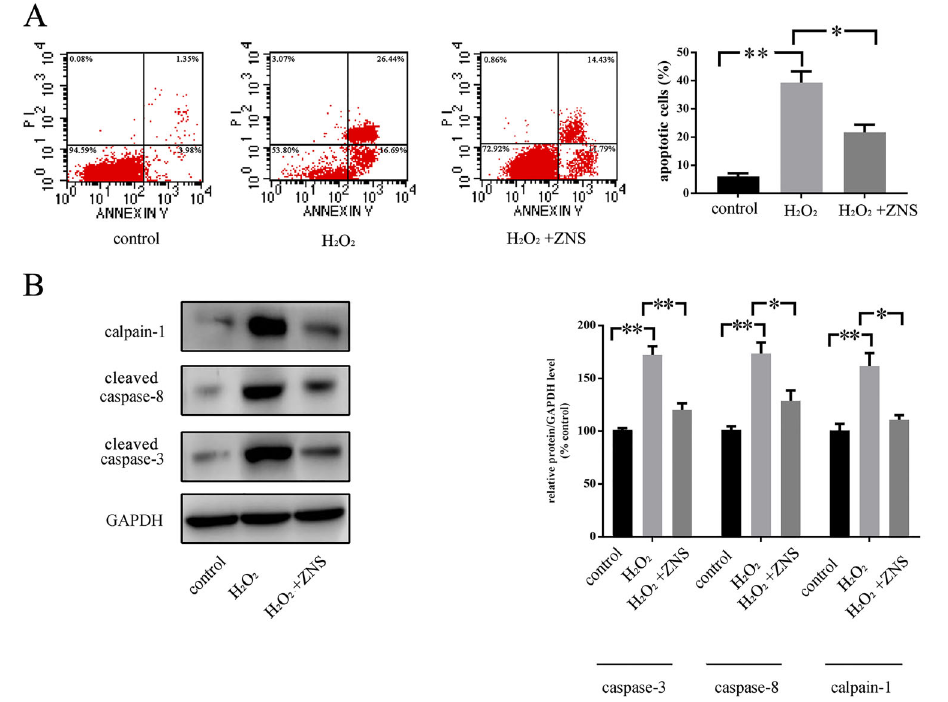
Figure 2. The cells received zonisamide (ZNS) or H 2 O 2 , for 24 h. A , Cells stained with annexin V and PI, showing the number of apoptotic (annexin V-positive) cells as the percentage of gated cells. B , Apoptosis-related protein expression in cells after different treatments via western blot (representative images and relative quanti fi cations are shown). All the experiments were performed in triplicate, and the data are reported as means ± SE (*P o 0.05, **P o 0.01 one-way ANOVA).